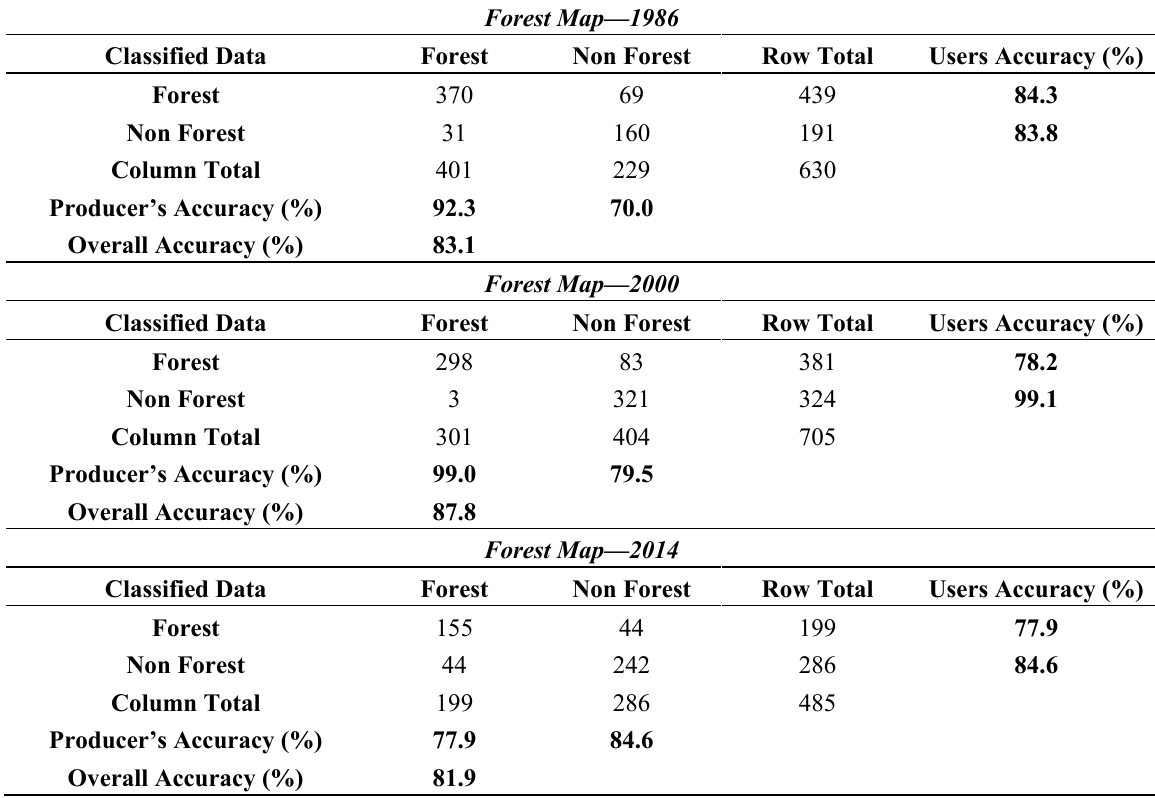
Table 2. Error matrix of 1986, 2000 and 2014 classified forest maps for Cross River State.